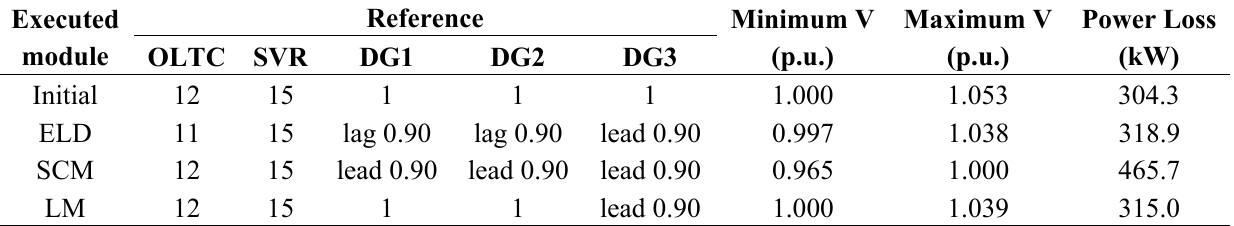
Table 8. Calculated references and corresponding network states for Case 2.